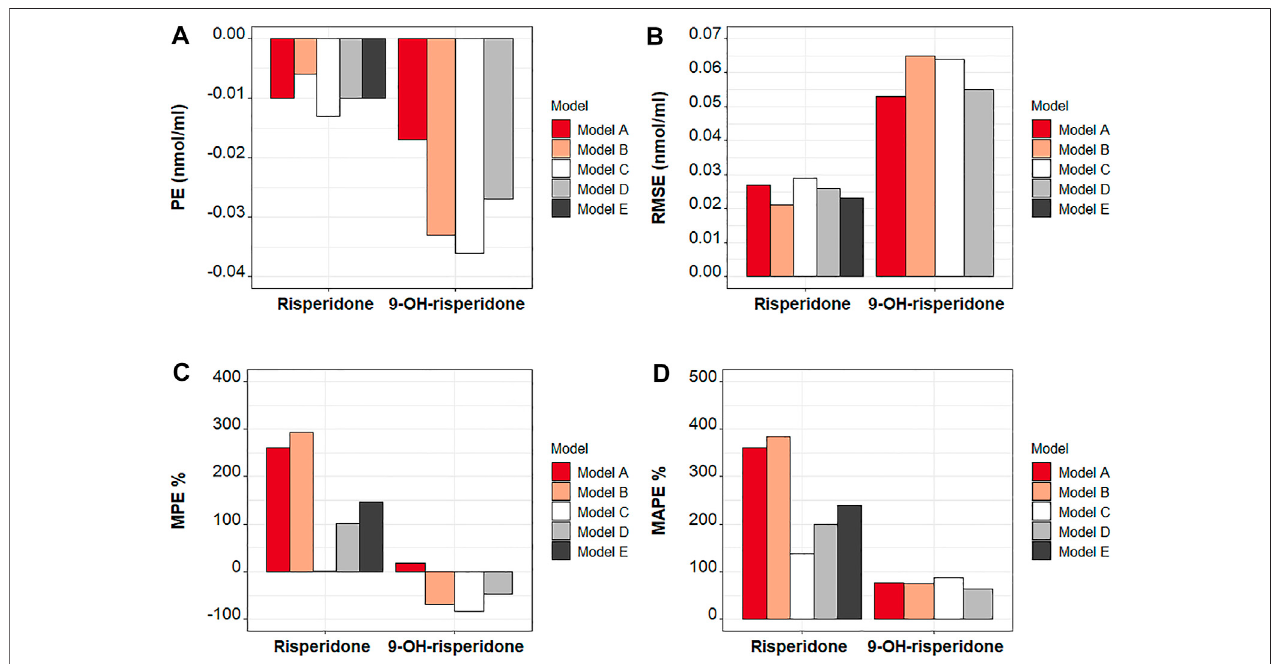
FIGURE 1 | Comparison of quantitative measures of bias and precision among the models included in the external evaluation analysis. Model (A) : Kloosterboer et al., 2021; Model (B) : Sherwin et al., 2012; Model (C) : Feng et al., 2008; Model (D) : Feng et al., 2008 with allometric scaling; and Model E: Thyssen et al., 2010. Precision was evaluated using the mean prediction error (PE) and the root mean square error (RMSE). Bias were evaluated using the mean percent error (MPE) and the mean absolute percent error (MAPE).